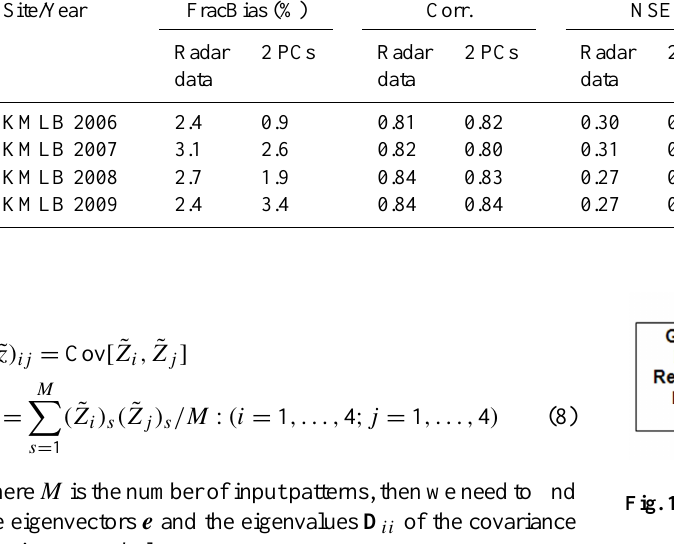
Table 4. The performance of the RBF NN using radar data versus 2 PCs as input. (Hourly rainfall accumulation). Site/Year FracBias (%) Corr. NSE